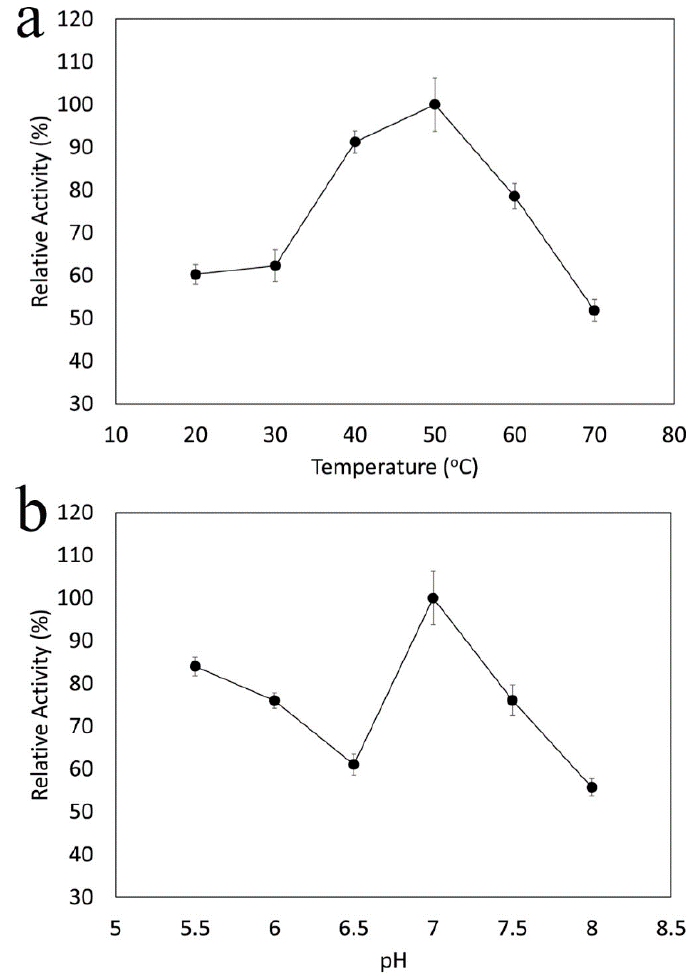
Figure 5. Optimal temperature ( a ) and pH ( b ) of I1P catalase activity. Temperature and pH range of catalase activity was determined at pH 7.0 and 50 °C respectively. Here, 100% of catalase activity represents the maximum activity measured. Measurements were performed in triplicate.